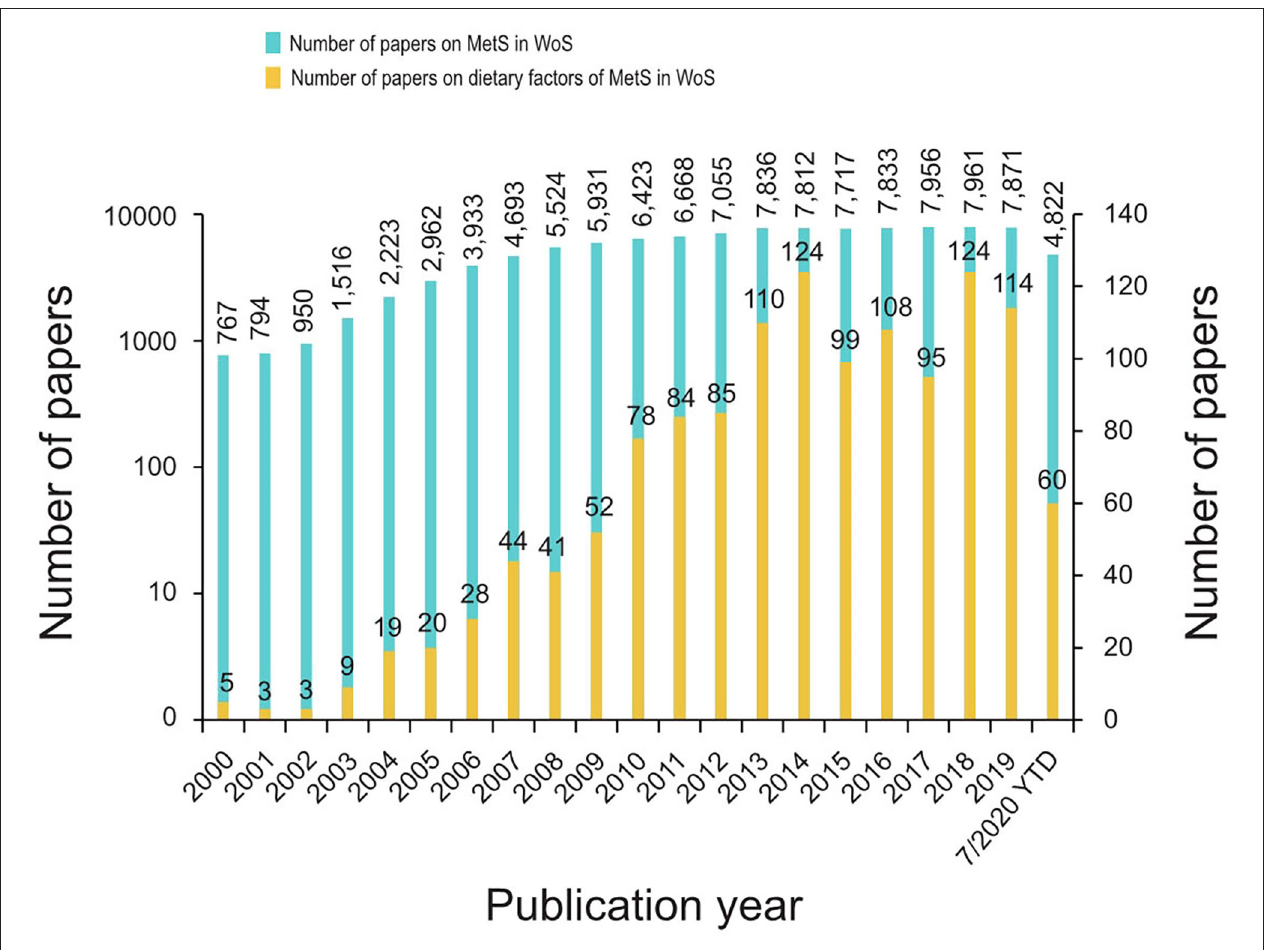
FIGURE 2 | The number of papers on dietary factors of MetS and all papers on MetS in WoS from 2000 to